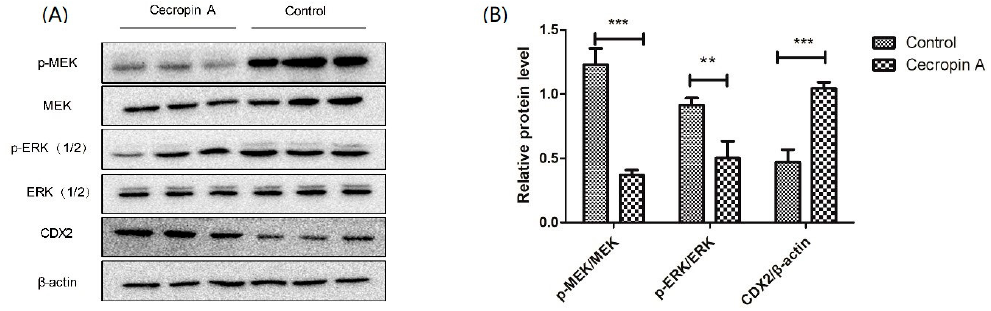
Figure 4. Cecropin A downregulates mitogen-activated protein kinase (MEK)/extracellular signal-regulated kinase (ERK) phosphorylation and upregulates CDX2 expression, n = 3. Western blotting analysis of p-MEK, MEK, p-ERK(1/2), ERK (1/2) and CDX2 showed that cecropin A downregulated the MEK/ERK pathway and increased CDX2 protein level ( A , B ). The results were confirmed by three independent experiments per treatment. Representative results of the three independent experiments are shown. Data (mean ± SEM) were analyzed with the Student’s t -test. Control: control group; Cecropin A: cells treated with cecropin A group. ** p < 0.01, *** p < 0.001.